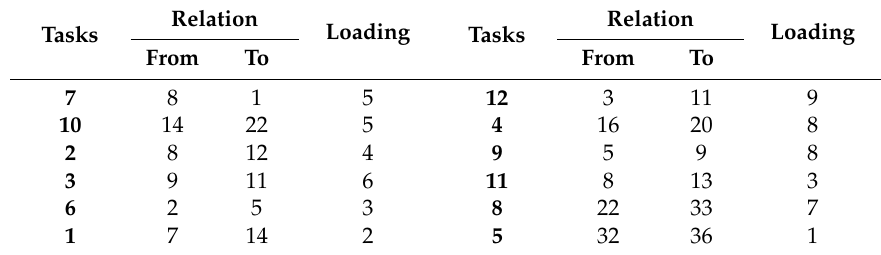
Table 3. Results of